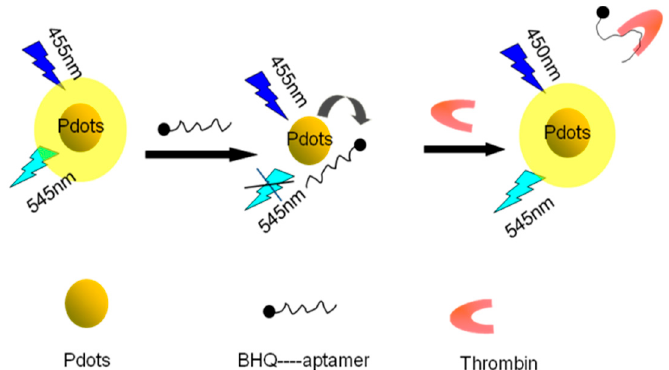
Figure 1. Schematic diagram of the detection of thrombin by high-efficiency energy transfer between functionalized Pdots and black hole quenching dye (BHQ).